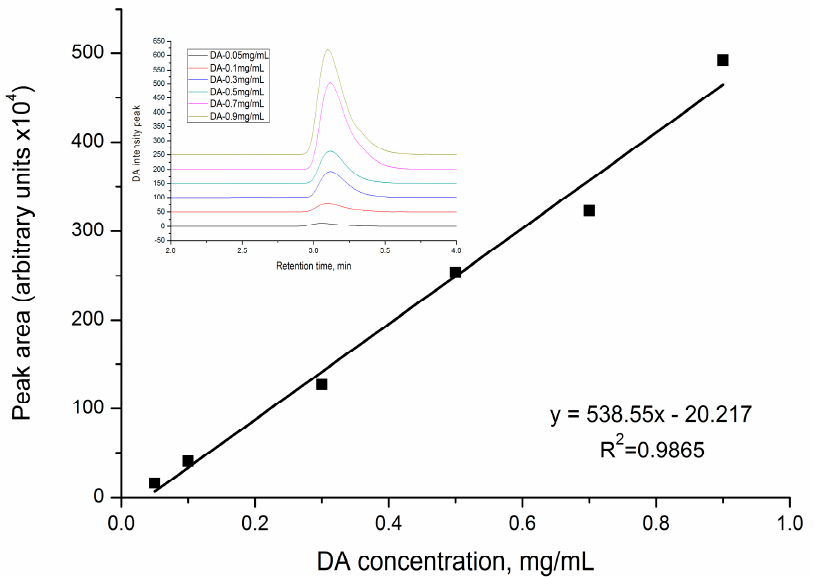
Figure 10. Calibration curve of DA as a function of the DA concentration and peak area of the recorded chromatogram.